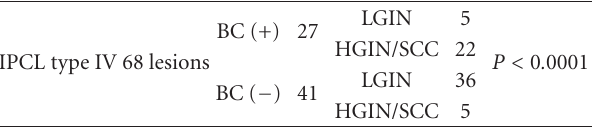
Table 4: BC pairing with IPCL type IV significantly improved the diagnostic accuracy in detecting squamous cell carcinoma including